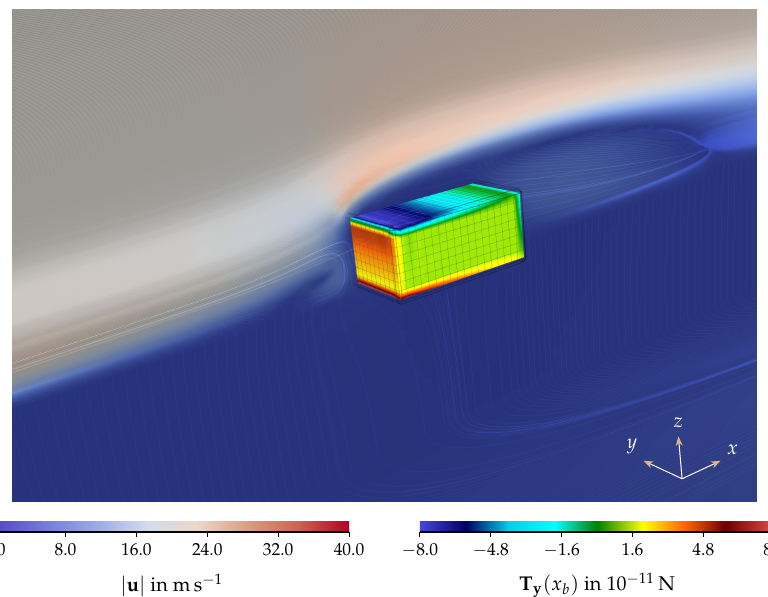
Figure 16. Detailed flow field featuring a single PM layer fragment coloured according to local contribution to torque T y ( x b ) . Streamlines exhibit local flow direction. Left colour scale indicates local flow velocity magnitude | u | . Porous substrate removed for visual